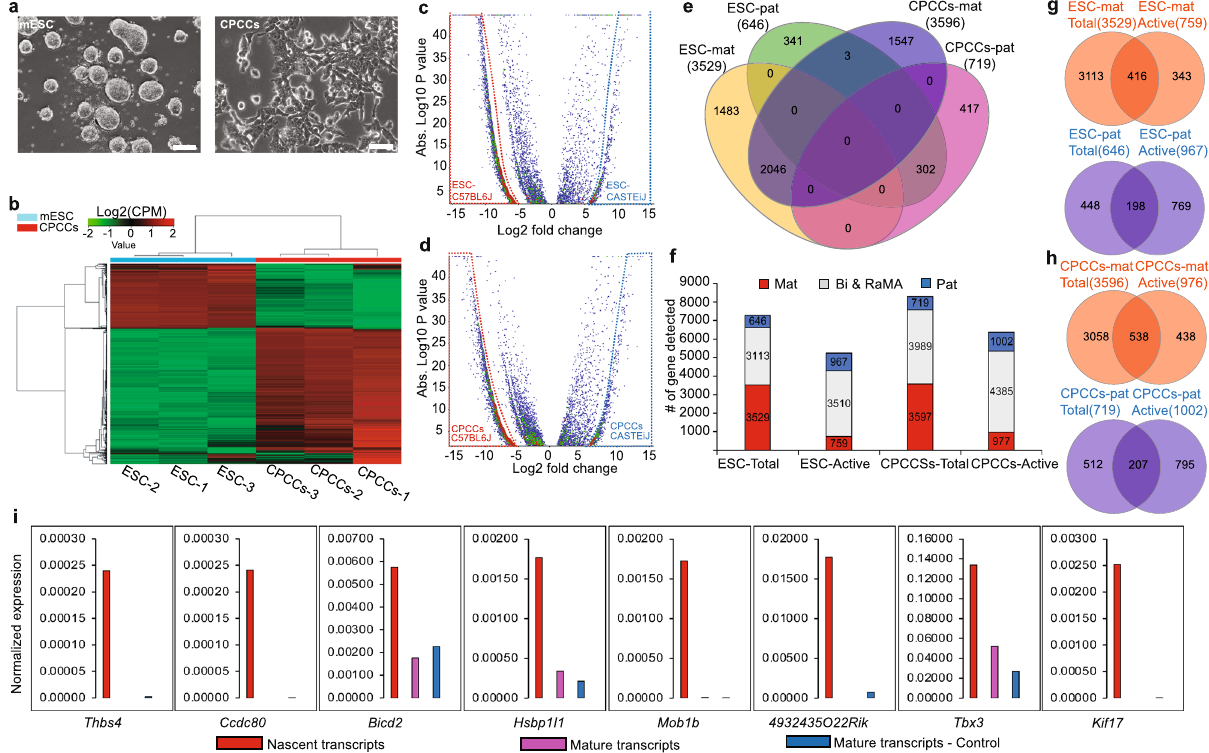
Fig.1|Allelicexpressionofautosomalmonoallelicgenes.a F1mESCsgrownin2i medium and in vitro derived CPCCs cultures. The representative images shown here from three independent biological replicates. Scale bar-100 μ